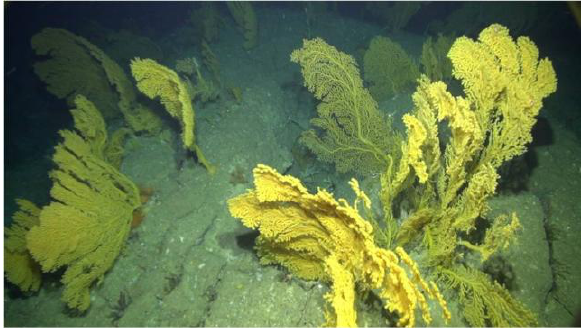
Figure 2. Example picture extracted from a video-sections that shows gorgonians and the rocky substrate at 528 m